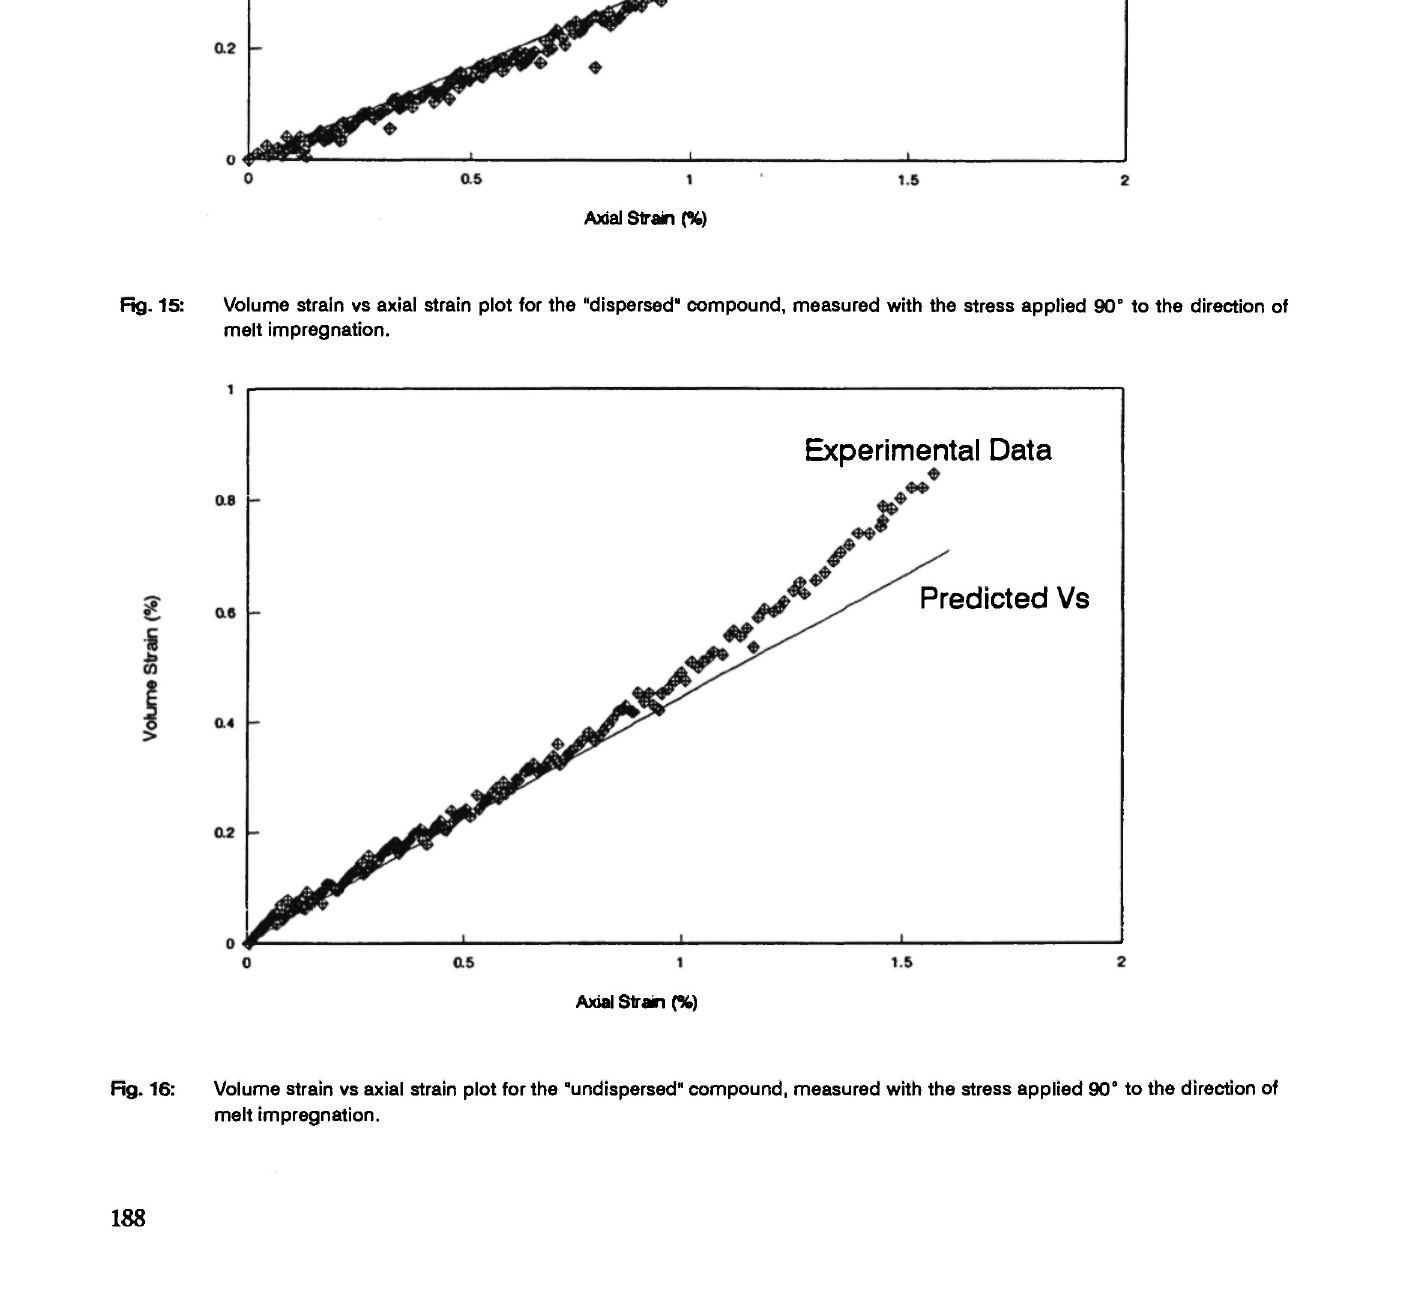
Volume strain vs axial strain plot for the "dispersed" compound, measured with the stress applied 90° to the direction of melt impregnation.